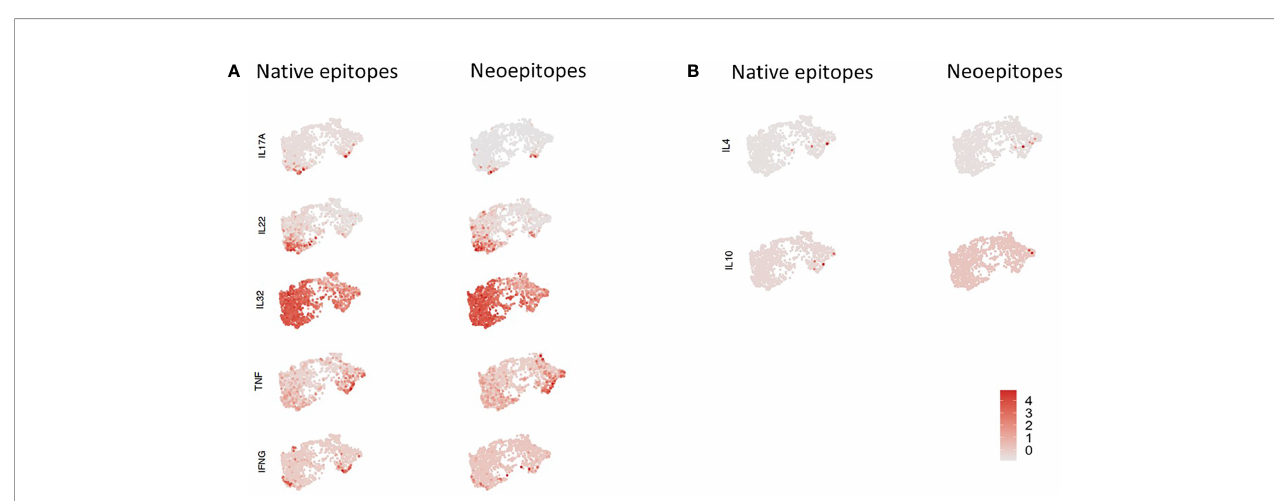
FIGURE 5 | PBMCs from subjects ND01 and ND02 were stimulated with native [proinsulin peptides: C13 – 32, C19-A3, C22-A5; GAD peptides: 115 – 125, 265 – 284) and neoepitopes (C-pep-IAPP1, C-pep- NPY, GAD 115-127 (120E), GAD 265-284 (272 cit)]. Antigen-responsive cells were identi fi ed by expression of CD154/CD69, and immune pro fi ling was conducted on single cells. (A) Cells were stimulated with native (right) and neoepitopes (left), and gene expression (depicted in pink) of (A) IL-17A, IL-22, IL-32, TNF- a , and IFN- g and (B) IL-4 and IL-10 was examined. Level of expression corresponds to greater intensity of color.